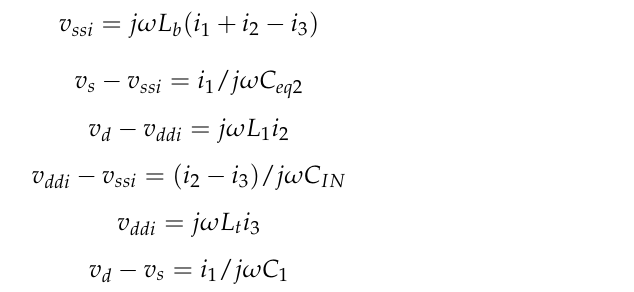
Figure 8. Circuit transformation: ( a ) an original circuit diagram of mESCO, ( b ) its small-signal equivalent circuit, and ( c ) a circuit model of mESCO to extract its common-gate voltage gain A CG . When v d is forced, what voltage appears at v s ? Seven variables (four voltages and three currents) among six equations were applied, as shown by (6) – (11).